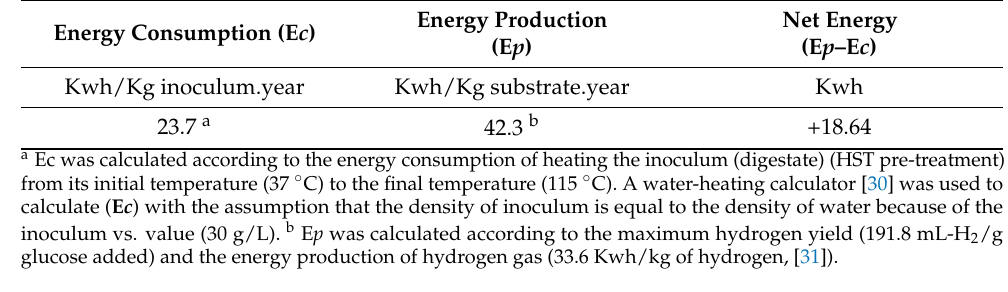
Table 4. Energy balance of BHP with HST pre-treatment based on 1 Kg substrate and 1 year of operation.